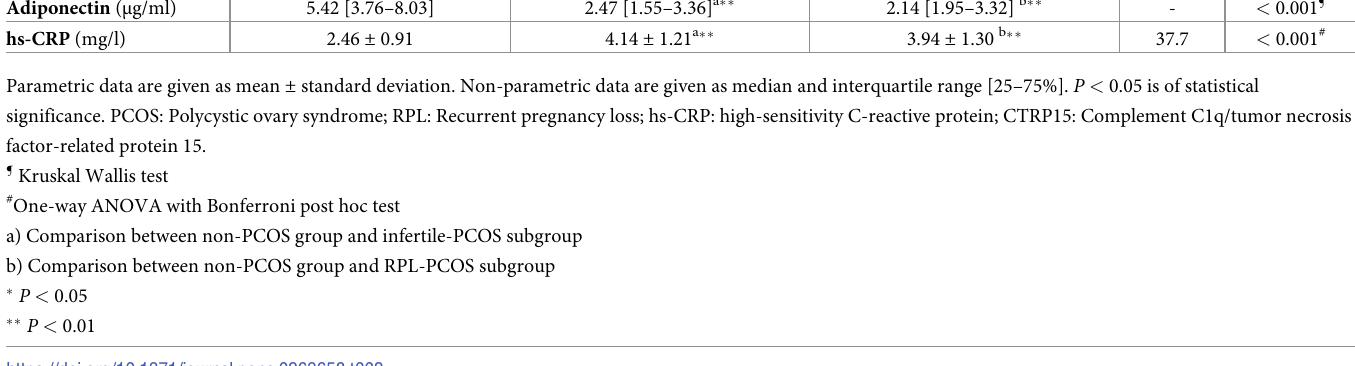
Table 2. Serum levels of CTRP15, adiponectin and hs-CRP.